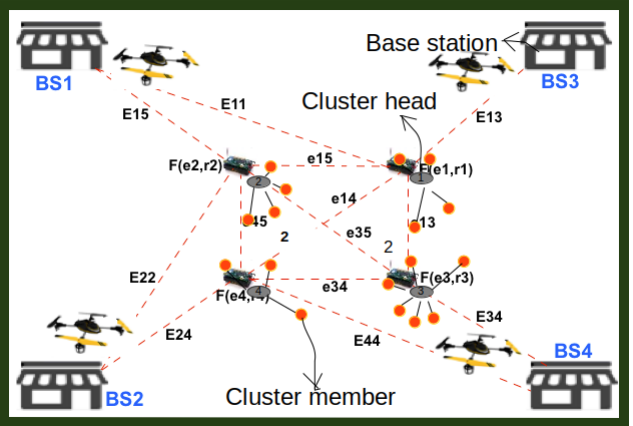
Figure 1. Cooperative data